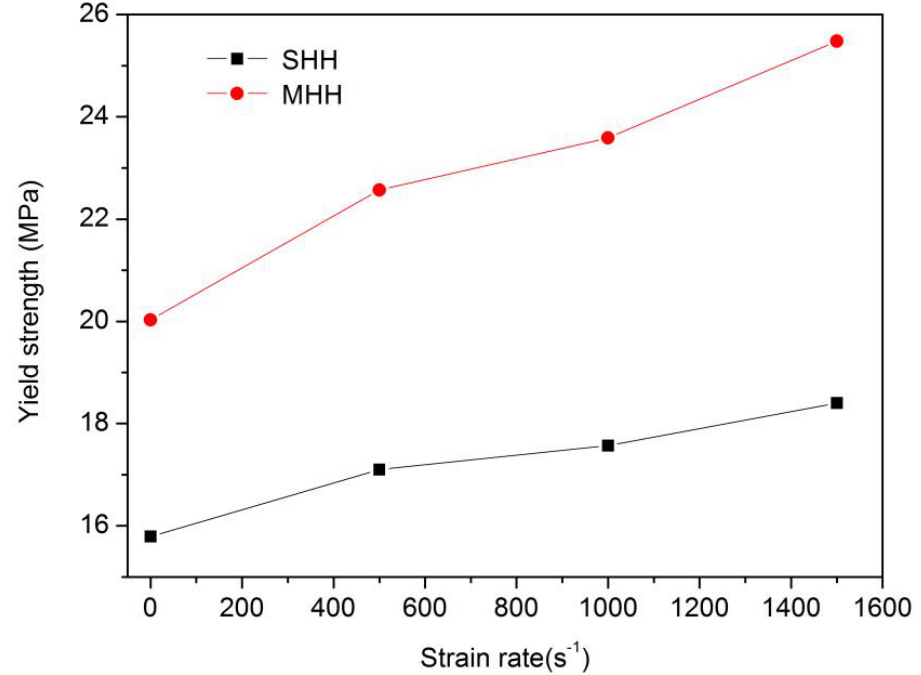
11 of 16 Figure 10. Dynamic stress–strain curve of resin hierarchical honeycomb materials: ( a ) MHH, ( b ) SHH. In the past, many scholars discussed the strain rate sensitivity of porous structures. Zheng et al. [39] pointed out that due to the change of material deformation, the strength of porous medium under high-speed impact loading is higher than that under quasi-static loading. However, under low-speed impact loading conditions, the strengthening mech- anism of material strength is still unclear. Figure 11 and Table 3 show the collapse strength of two hierarchical honeycomb materials with different levels under different strain rates.